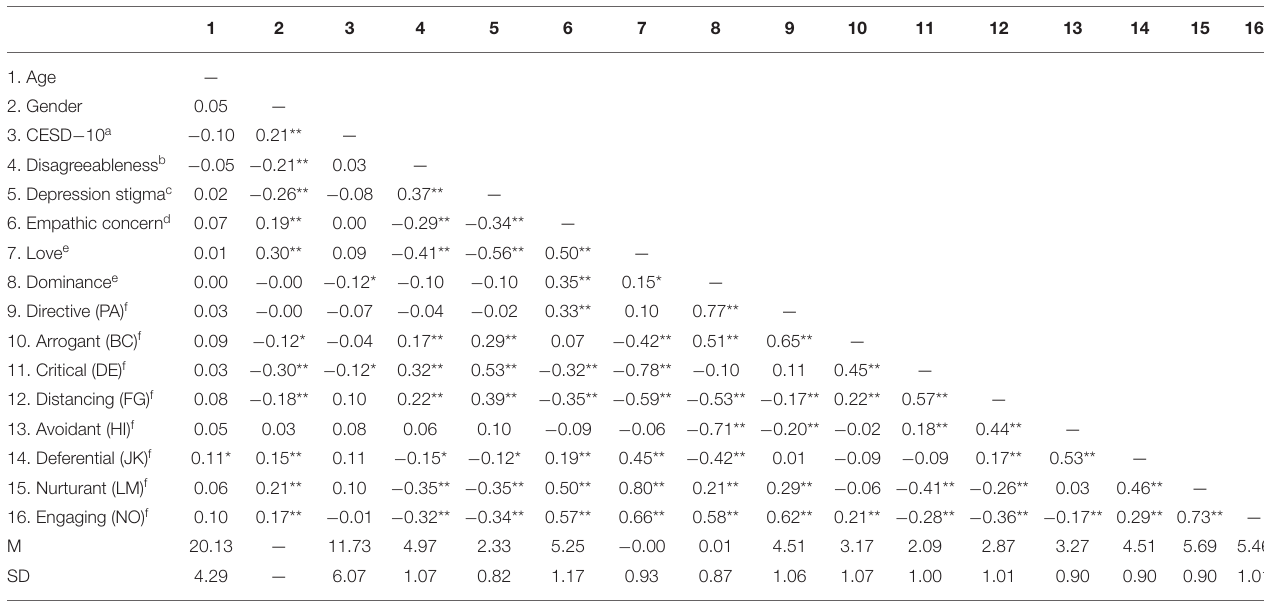
TABLE 2 | Descriptive statistics and correlations in Study